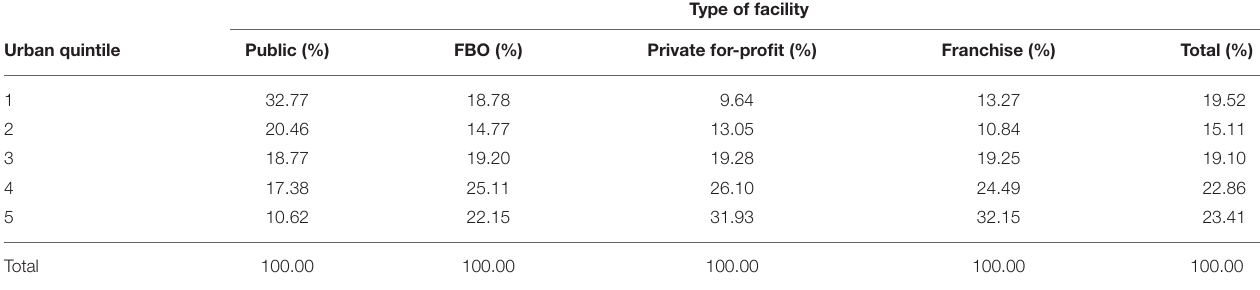
TABLE 6 | Proportion of Clients in Each Urban Wealth Quintile, by